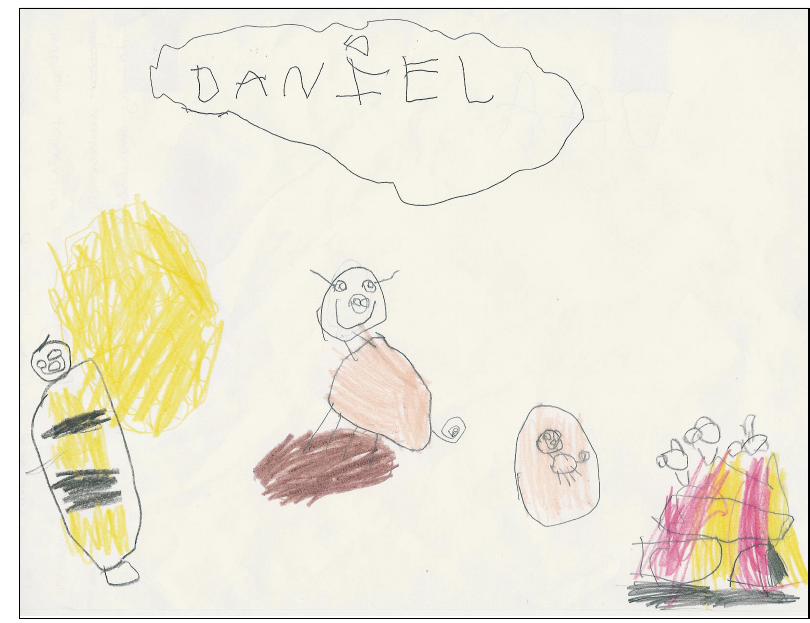
Figura 1. Caso 1 “Era uma vez um porquinho que um dia teve um filhotinho e teve um OVO bem grande, daí as abelhas roubaram, daí o policial pegou e roubou das abelhas e daí fez churrasquinho das abelhas e